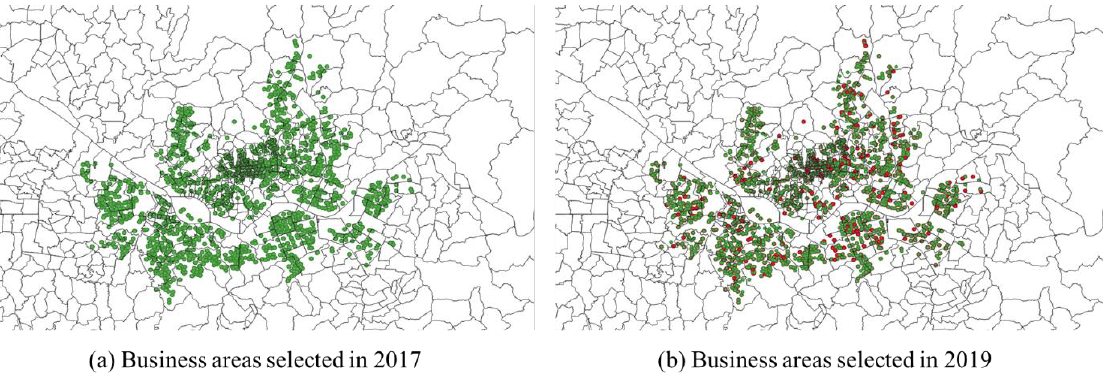
Figure 3. Target business areas in 2017 and 2019 (map data source: [66]). Note: Maps were created by the authors with analysis results and a data source publicly available.